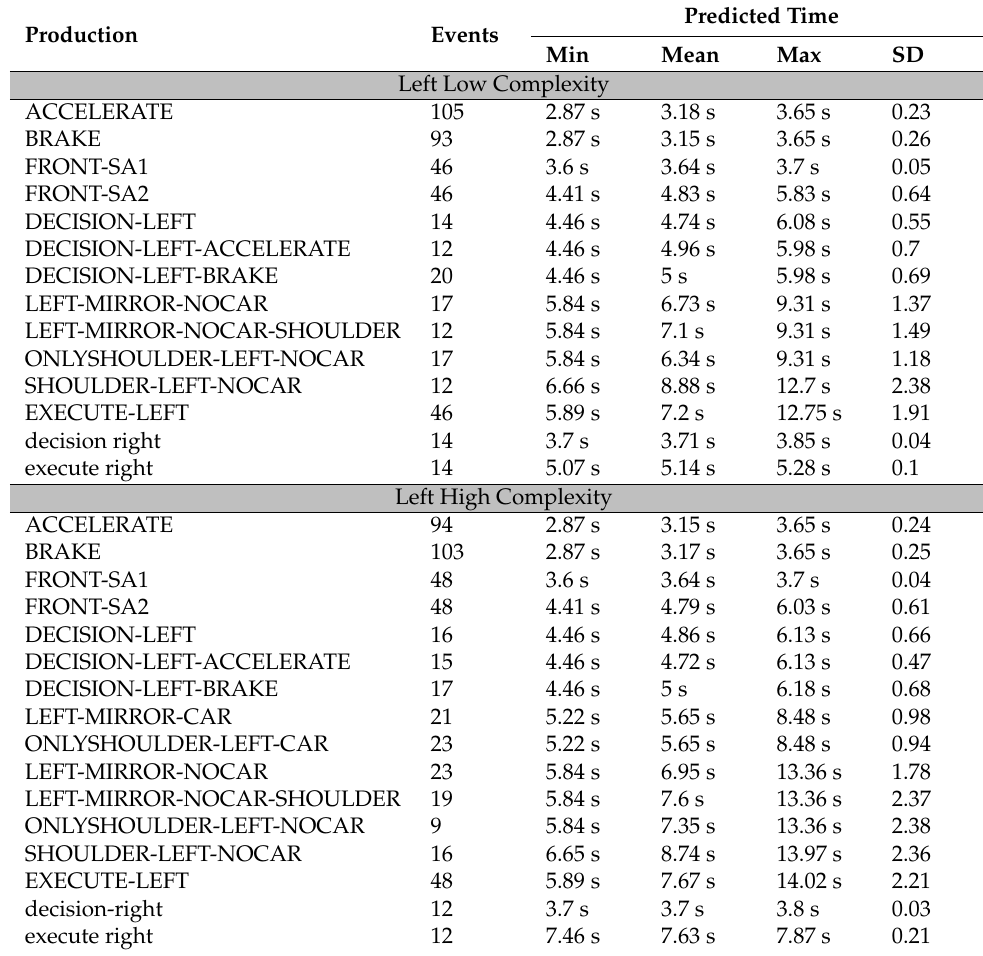
Table 3. Predicted time statistics of the cognitive model with a lane change left maneuver. Represen- tation of minimum (Min), mean, and maximum (Max) values over N = 60 trials. Wrong decisions are in lower case letters (source: own